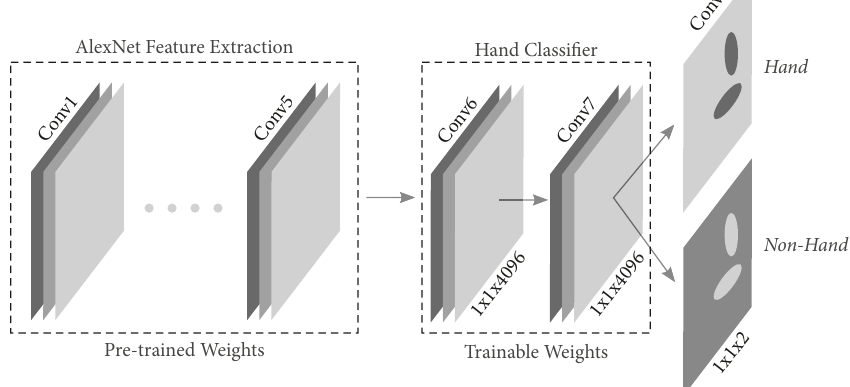
Figure 4: A modified version of AlexNet for hands localization (“Conv” stands for a convolutional layer). An AlexNet is trained on “hands” and “non-hands” images. Fully connected layers are replaced with convolutional layers with the same weights of the fully connected layers.